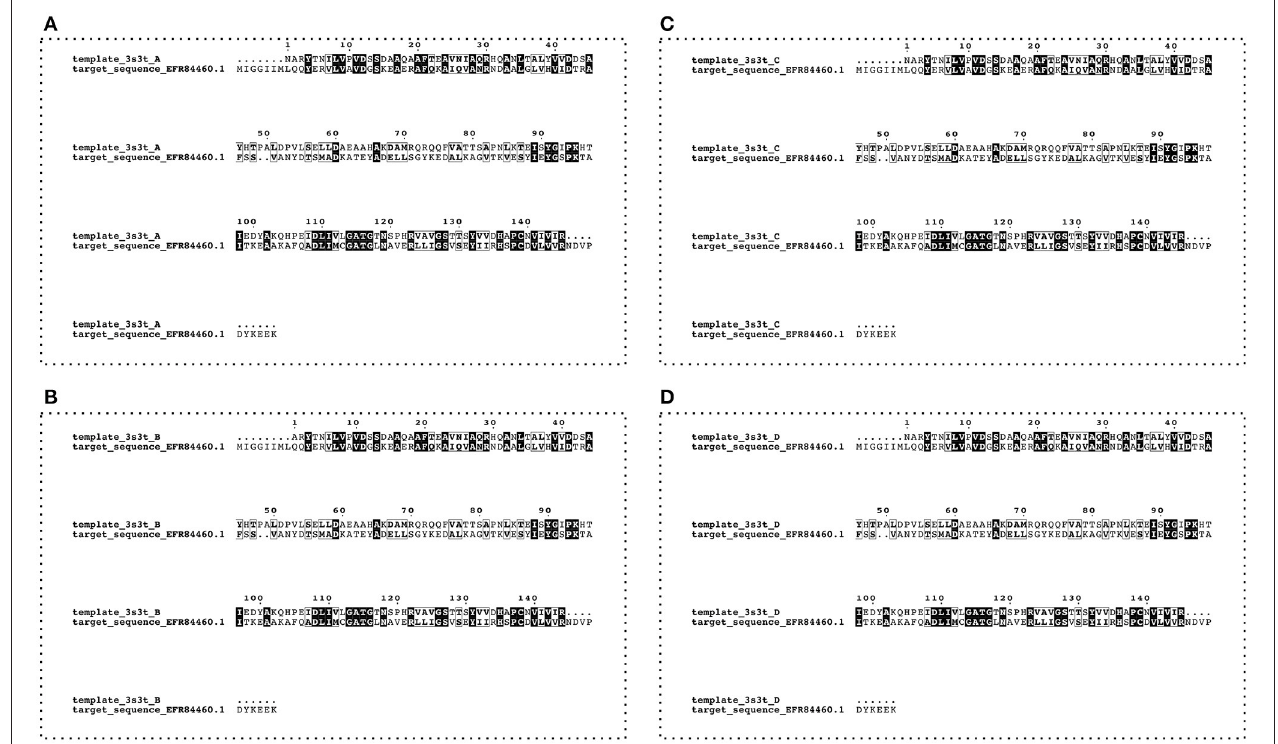
FIGURE 1 | Alignment between target (Uniprot accession number A0A0E1Y4Z4— L. monocytogenes FSL F2-208) and template (four chains—A, B, C, and D —from PDB code:3s3t— Lb. plantarum ) USP sequences. Conserved residues are highlighted by the